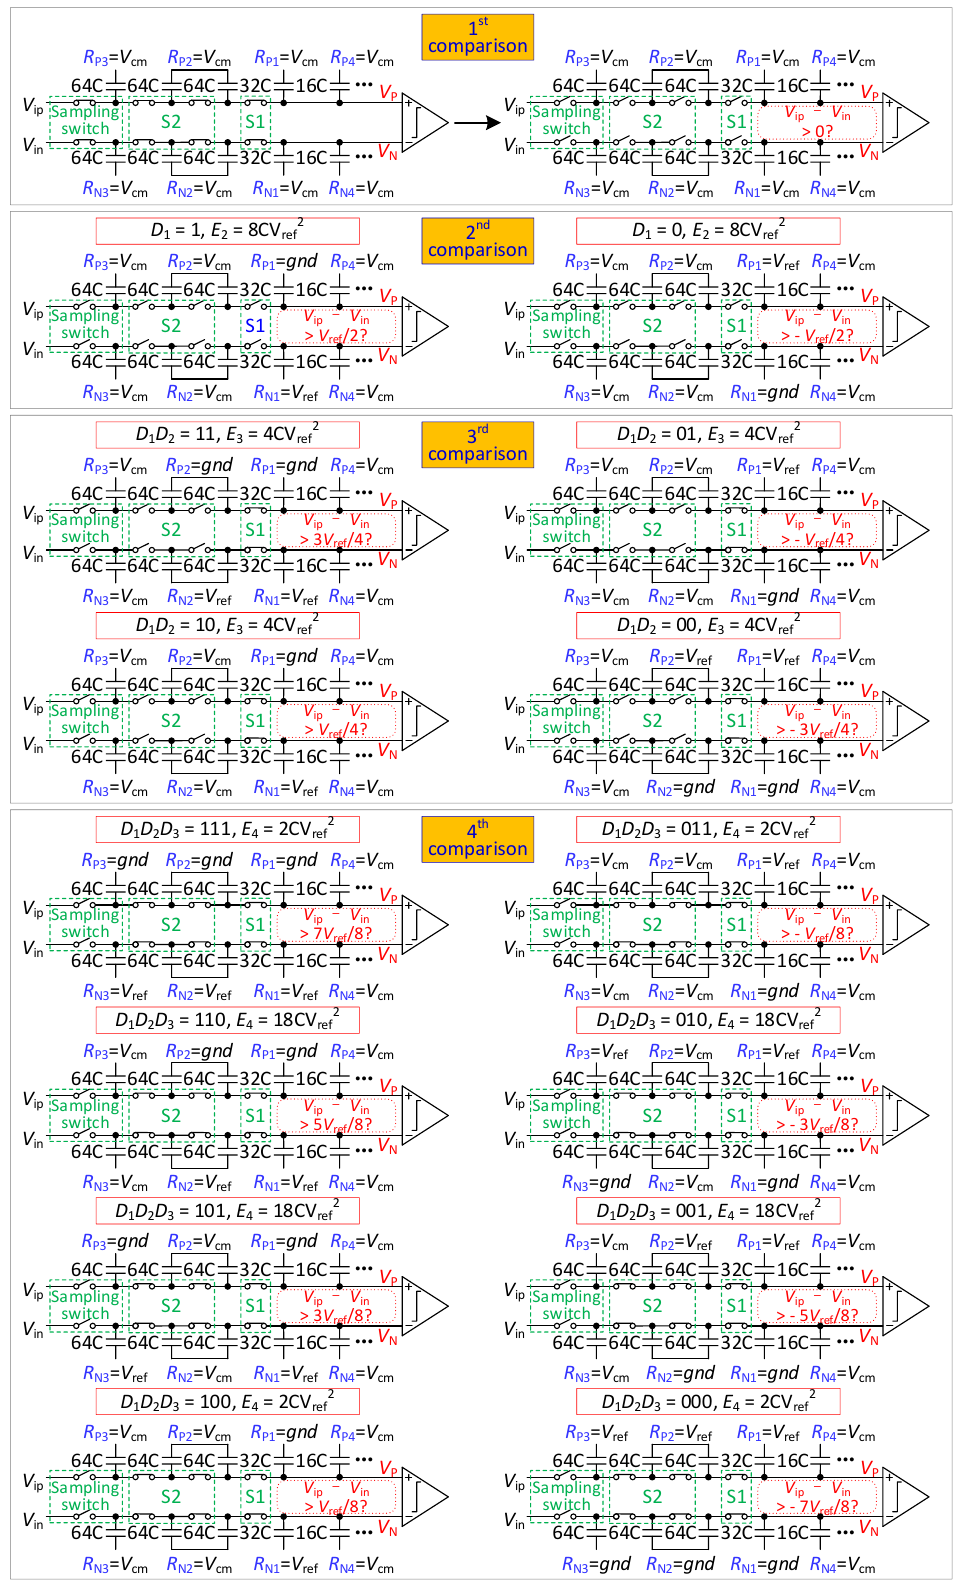
Figure 4. The 1st to 4th comparison diagram of the proposed 10-bit mode switching scheme.